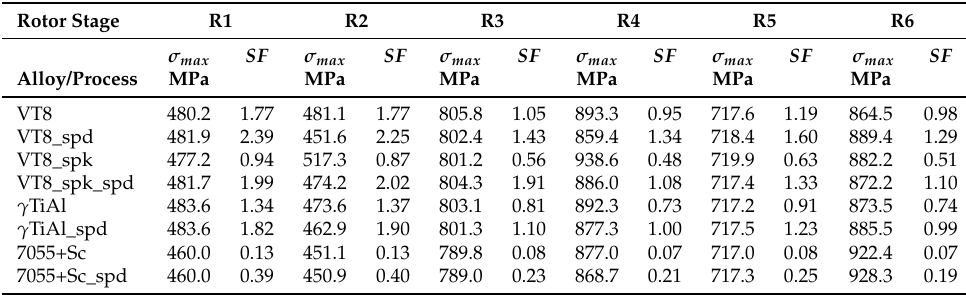
Figure 8. Von Misses stress in blades and vanes made from VT8_spk_spd in engine emergency mode. Table 5. Equivalent stress and static safety factor of blades made from candidate materials.